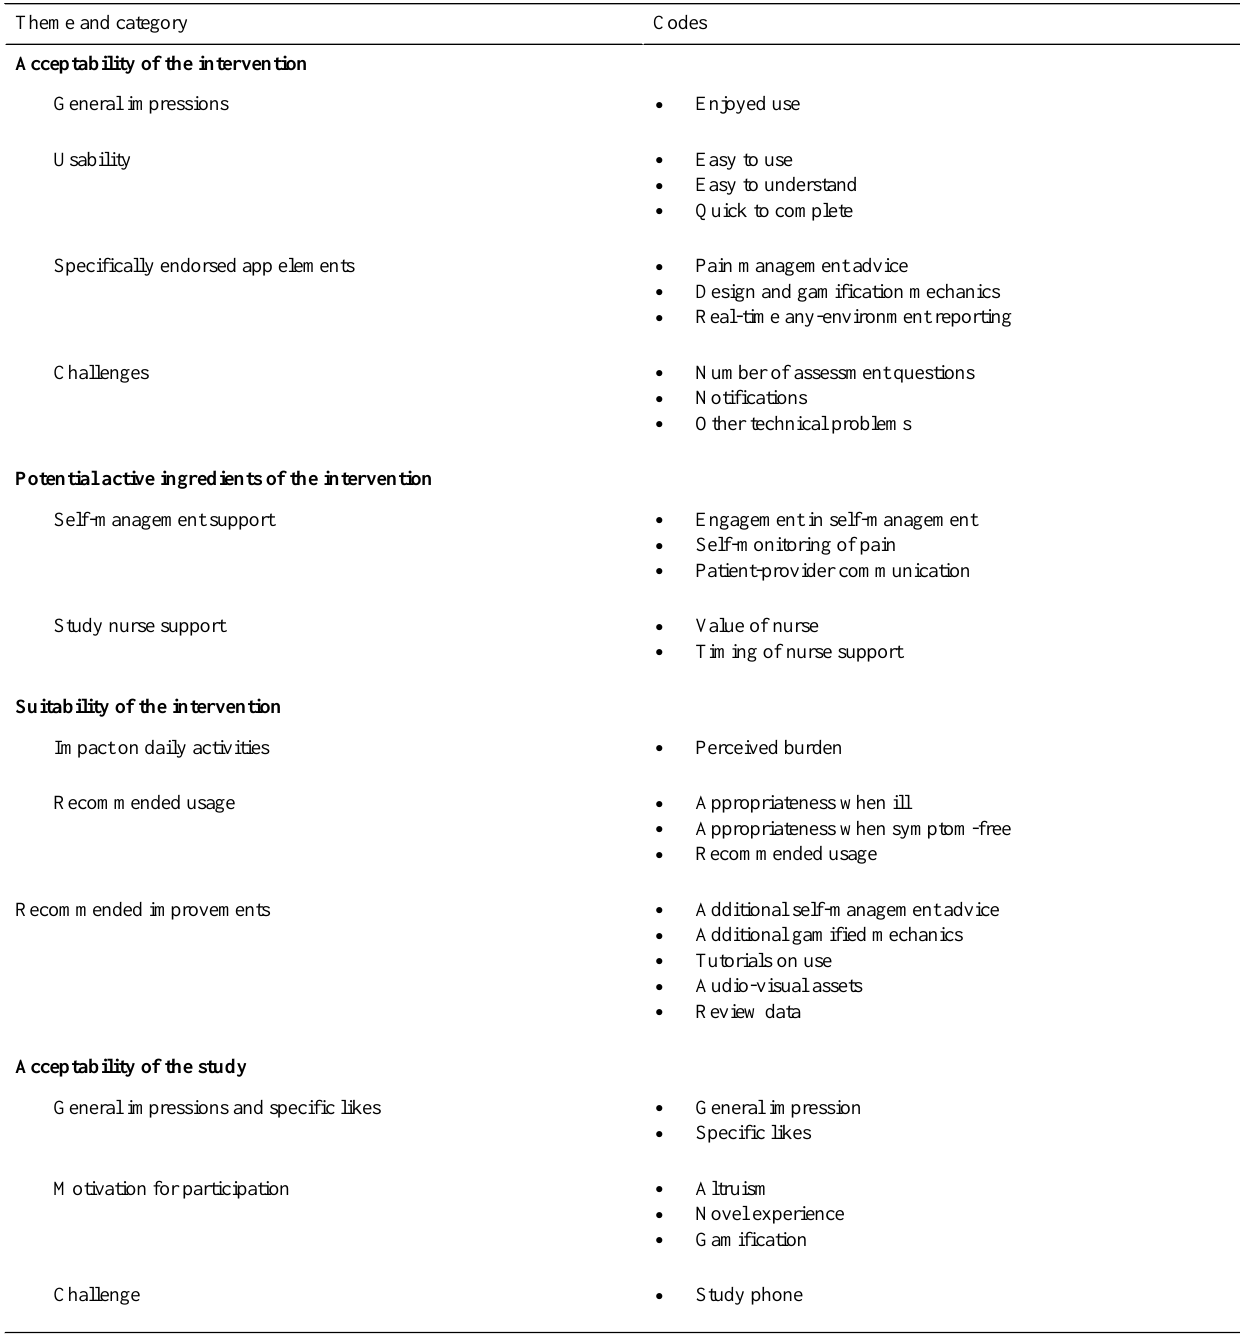
Table 1. Post-pilot study interview themes, categories, and codes. CodesTheme and